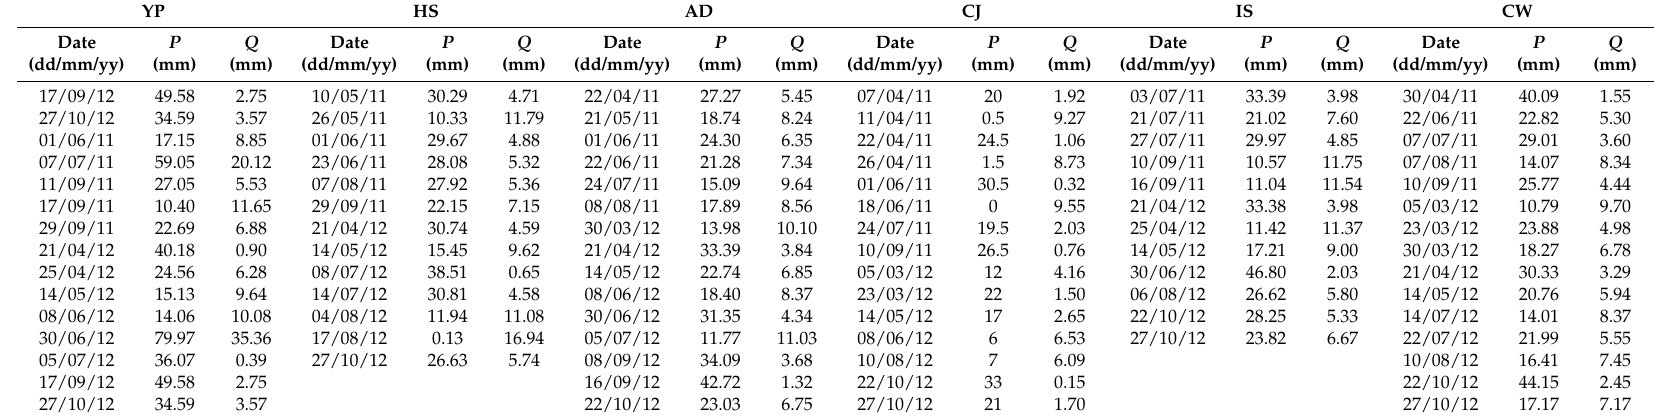
Table 4. Main properties of selected rainfall–runoff event for validation of runoff proxy variables of antecedent wetness conditions: rainfall ( P ) and direct runoff ( Q ).